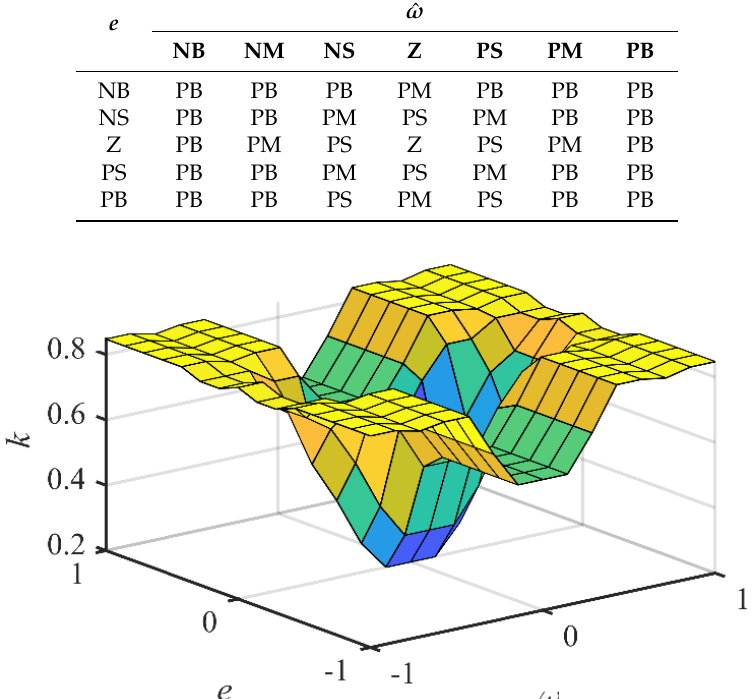
Table 1. Fuzzy reasoning rules for output k .